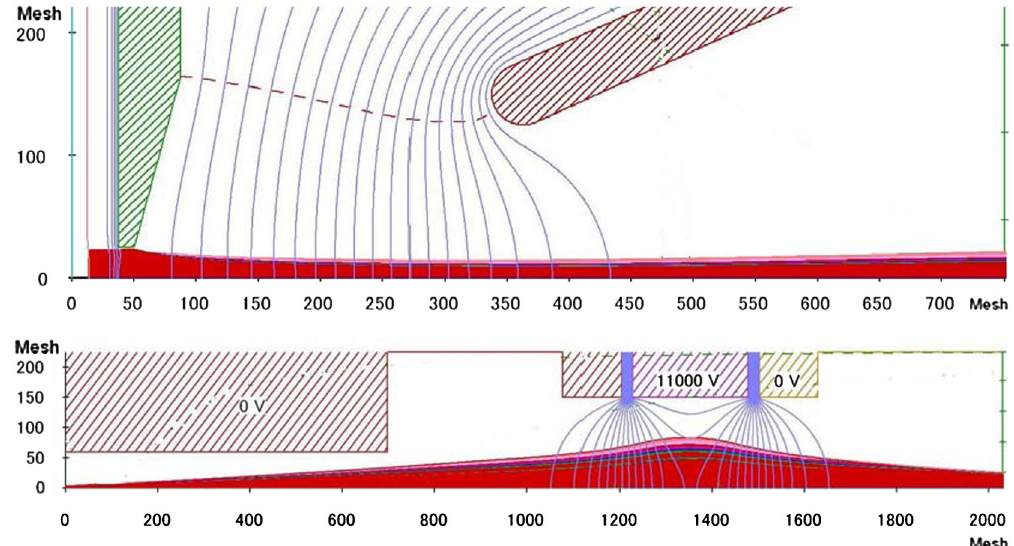
FIG. 5. Beam envelope from cathode to anode and from anode through Einzel lens ( IGUN simulation result). Units are mesh size in simulation ( 20 (cid:1) m in this calculation).